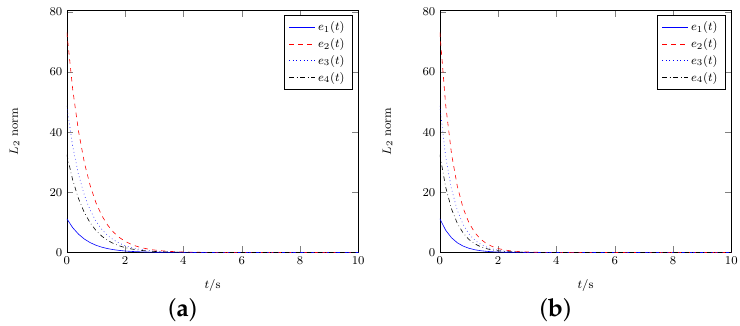
Figure 5. The evolution of state L 2 norms about estimation error system. ( a ) L 2 norm without consensus. ( b ) L 2 norm with consensus.